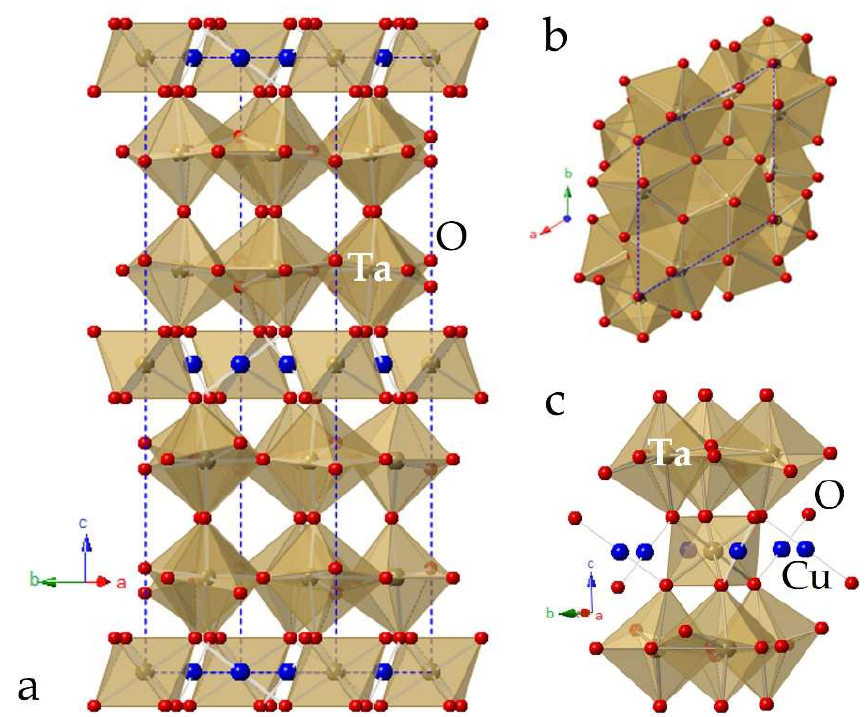
Figure 1. Structural views of Cu 3 Ta 7 O 19 showing the ( a ) unit cell, ( b ) coordination geometry of the layers of TaO 7 pentagonal bipyramids, and ( c ) coordination of the TaO 6 octahedron and neighboring, linearly-coordinated Cu(I) cations. Atom types are labeled.